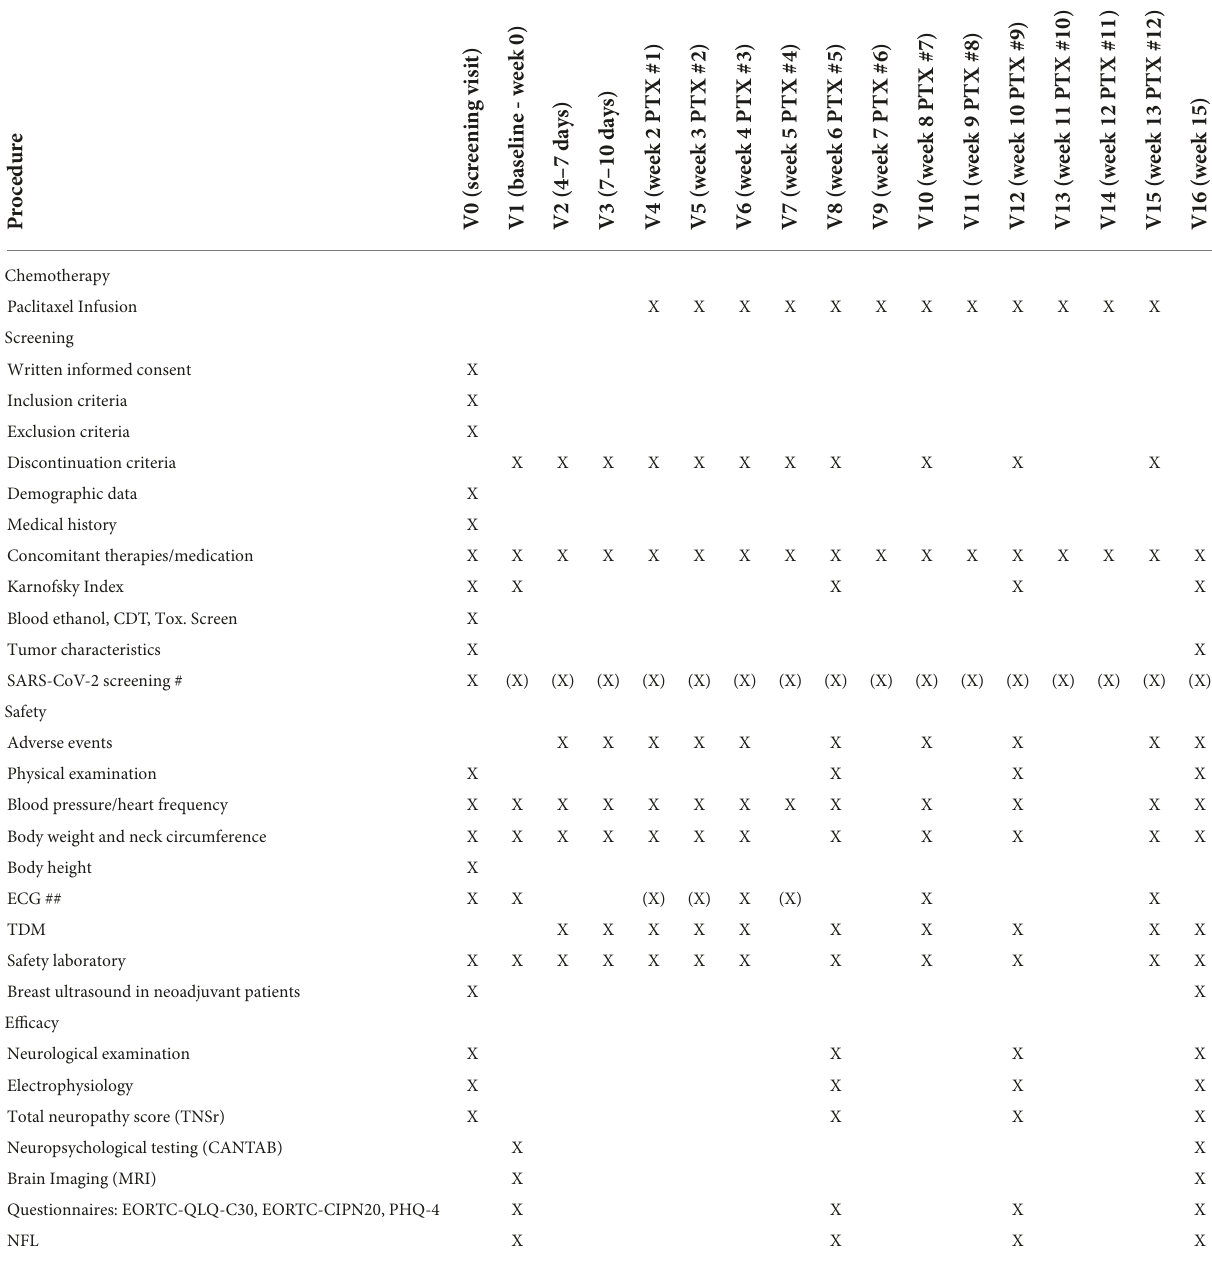
TABLE 2 Overview of study visits and relevant procedures per visit for patients receiving weekly (nab-) paclitaxel infusions (PTX q1w).